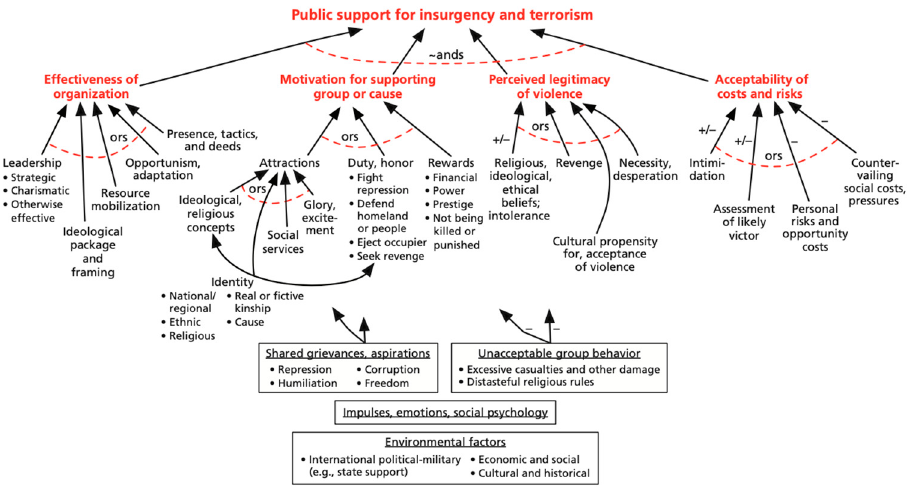
Figure 8. A factor tree model of public support for insurgency and